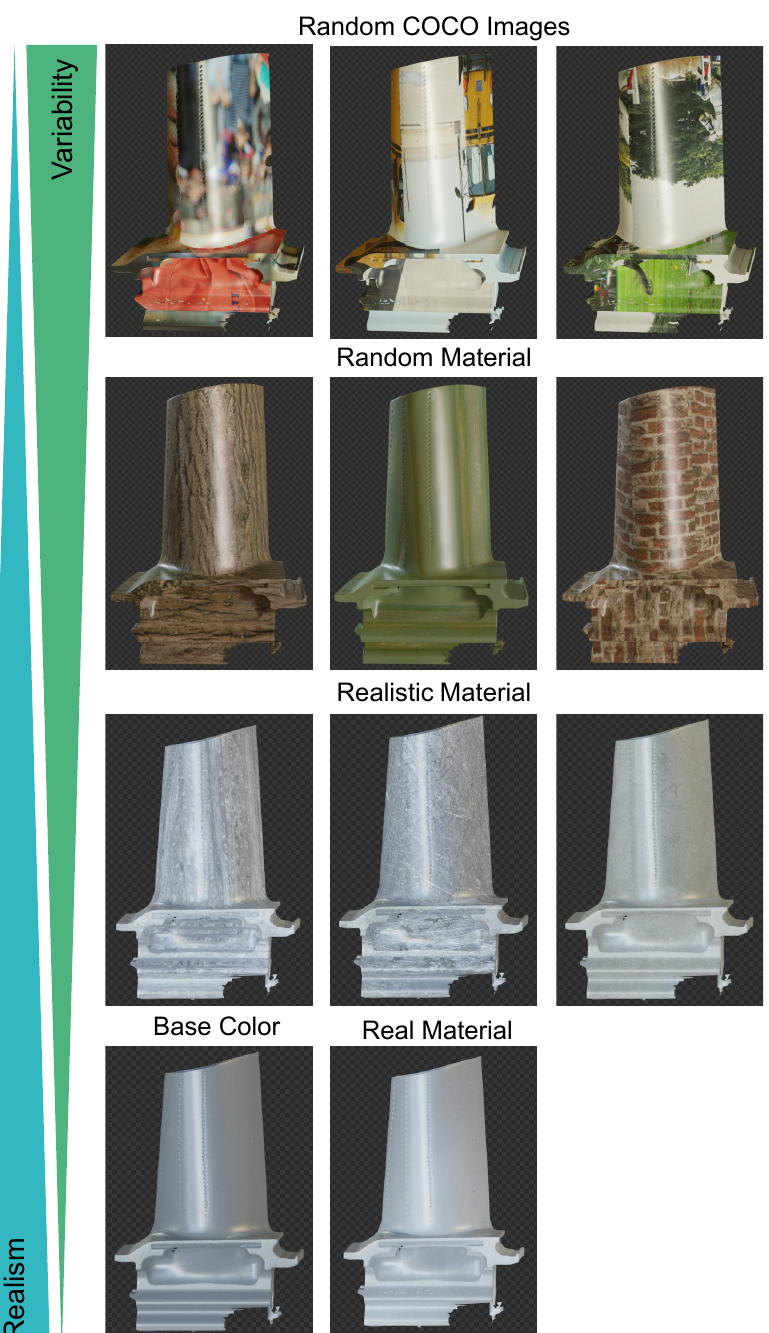
Figure 7. Examples of different textures that were used. We compare random COCO images, random materials, realistic materials, real material created from photographs of the turbine blade and a single base color against each